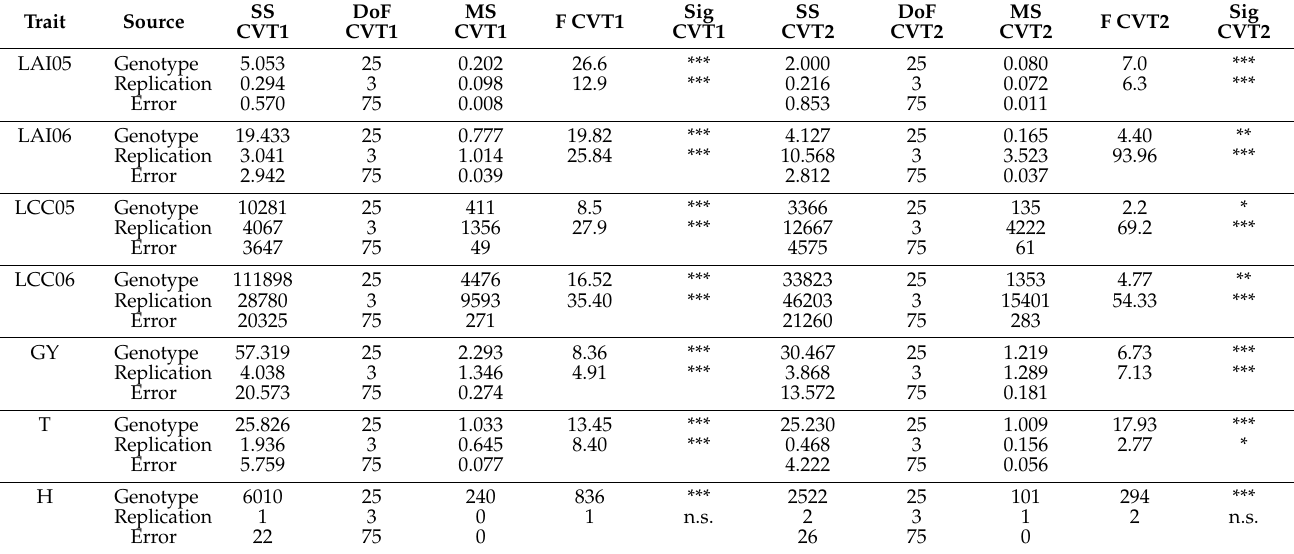
Table A3. ANOVA for CVT1 and CVT2. Tillering: T; plant height: H; sum of squares: SS; de- gree of freedom: DoF; mean squares: MS; F critical: F; significant: Sig; *— p ≤ 0.05; **— p ≤ 0.01; ***— p ≤ 0.001; n.s.—not